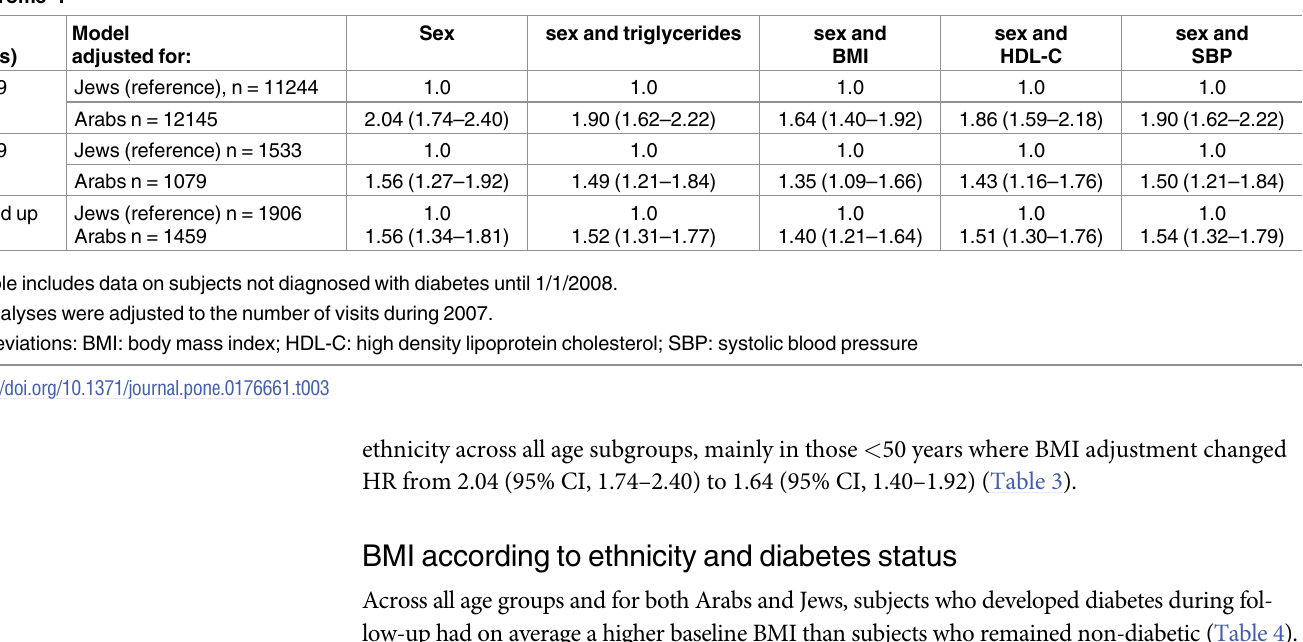
Table 3. Cox proportional hazard ratios (95% confidence interval) for incident diabetes by ethnicity, age, sex and components of the metabolic syndrome * .